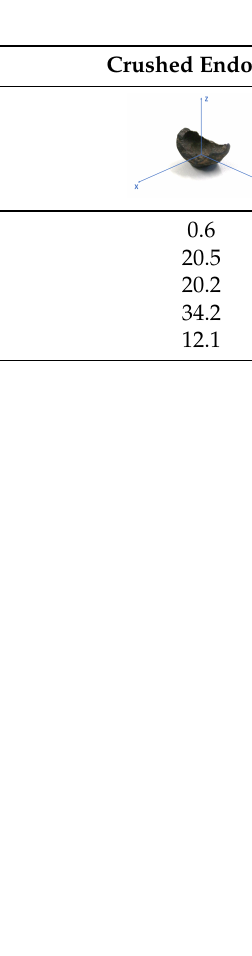
Figure 8. Particle size distribution of crushed granite and endocarp.